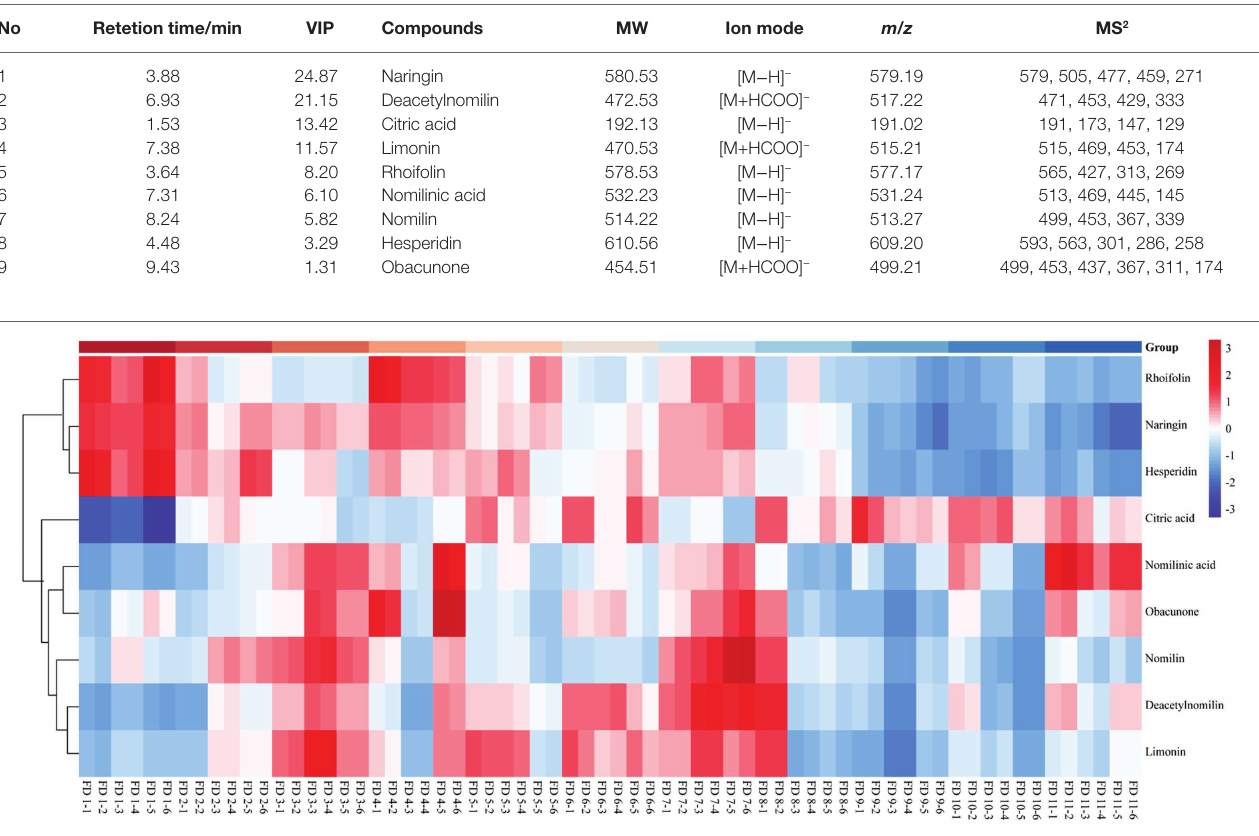
TABLE 1 | Identification of differential metabolites during the growth period.